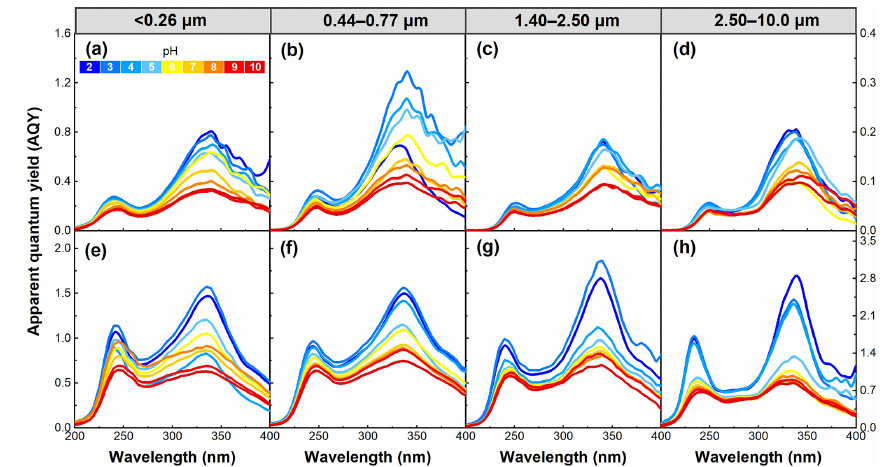
Figure 10. pH dependence of apparent quantum yield (AQY) for WSOC in particles of different sizes in summer (a–d) and winter (e–h) in the pH range of 2–10.